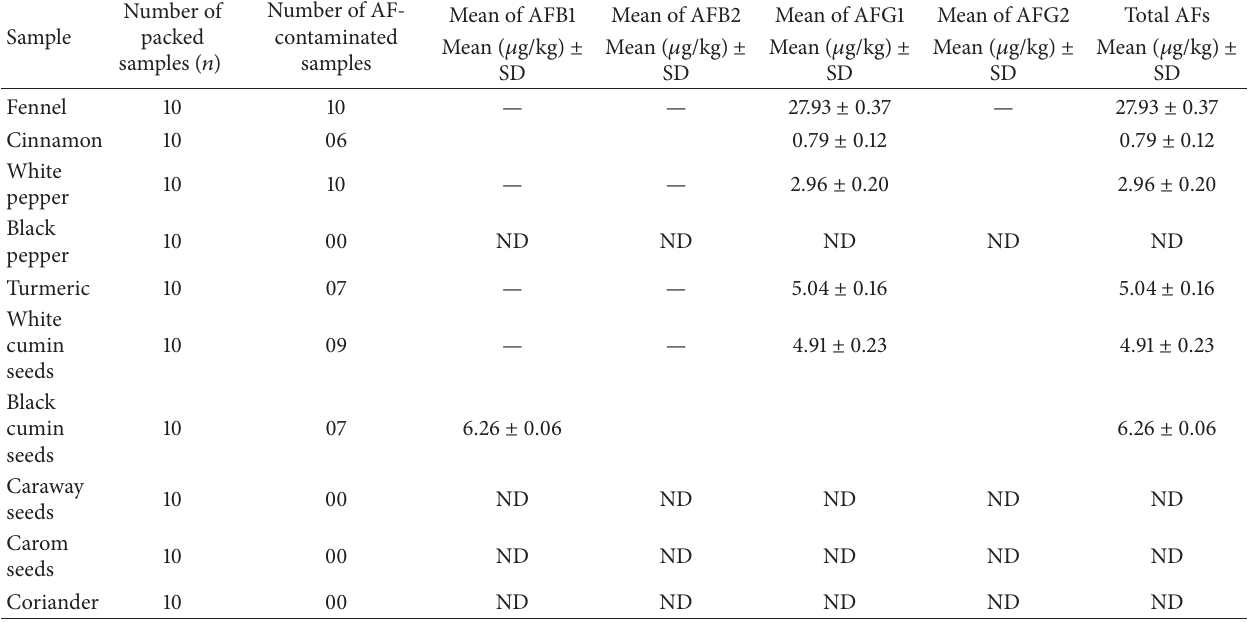
Table 2: Incidence of aflatoxins in packed spice samples.